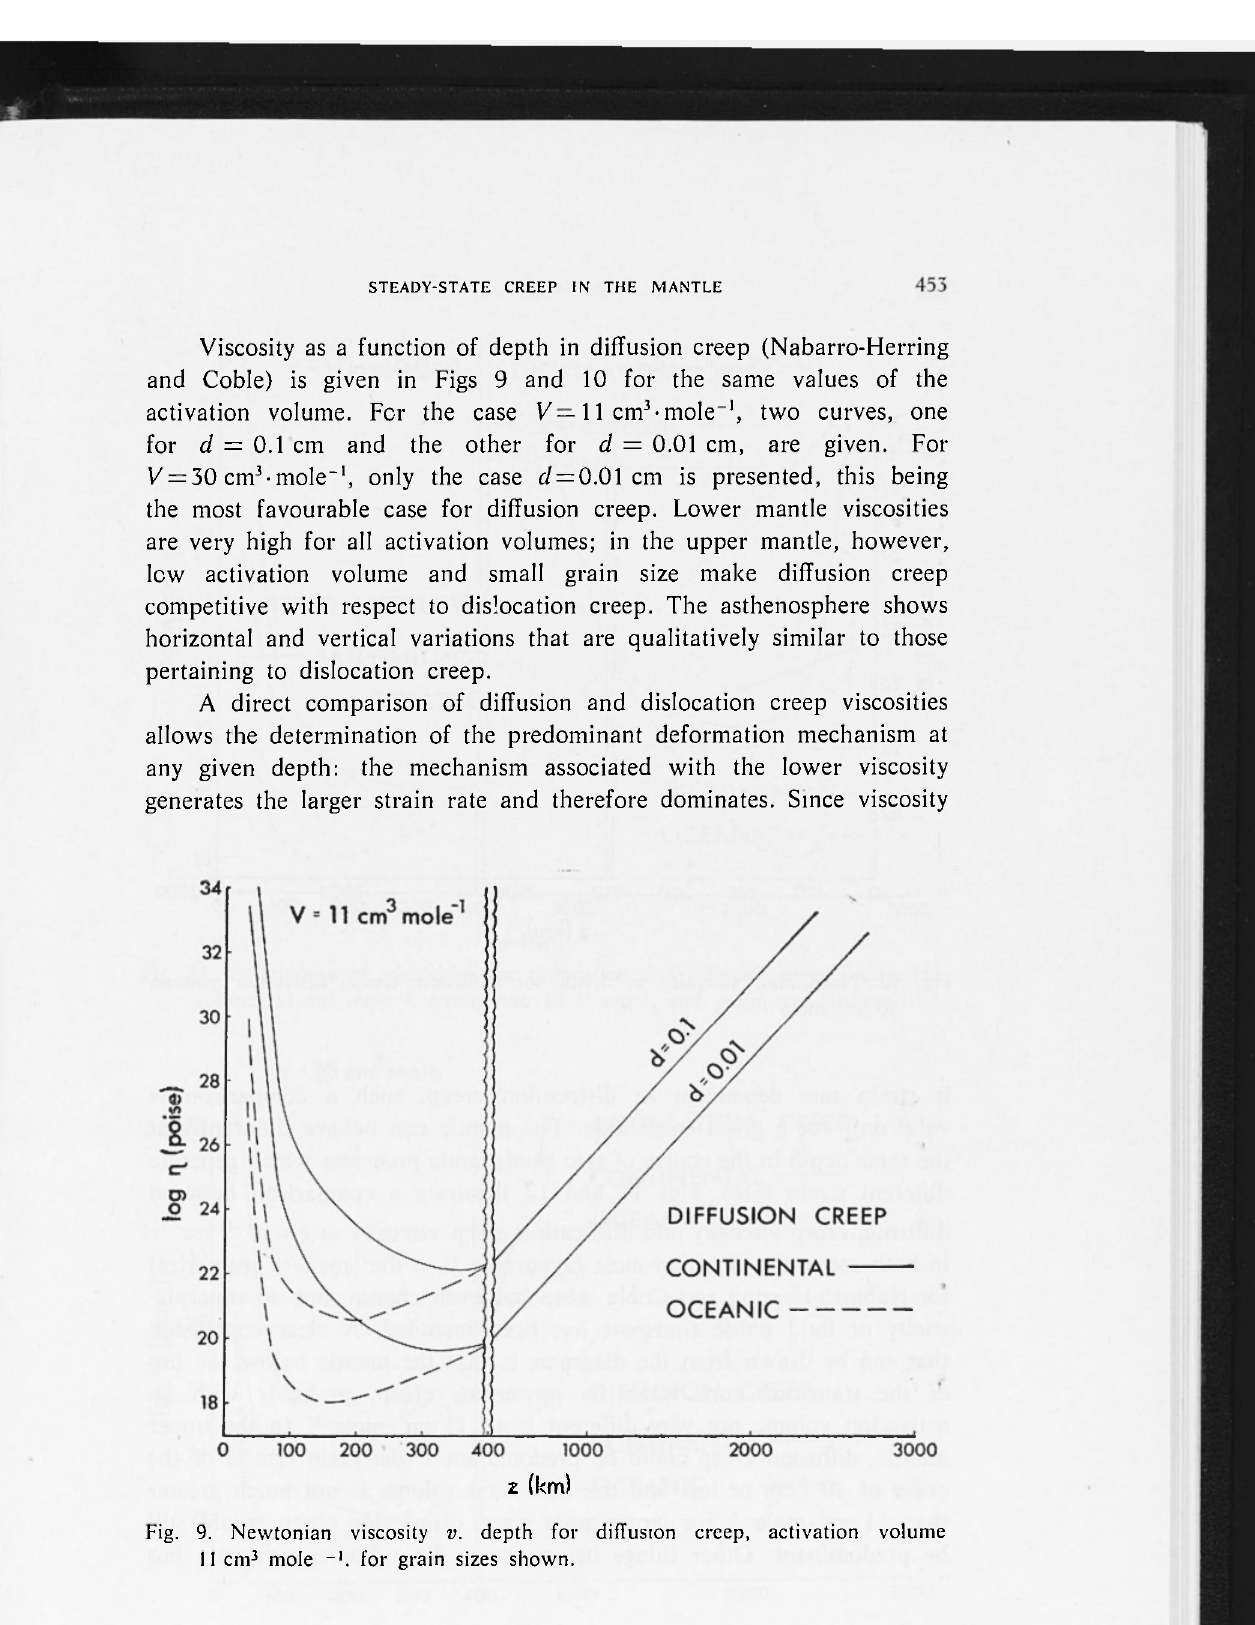
Fig. 9. Newtonian viscosity v. depth for diffusion creep, activation volume 11 cm 3 mole for grain sizes